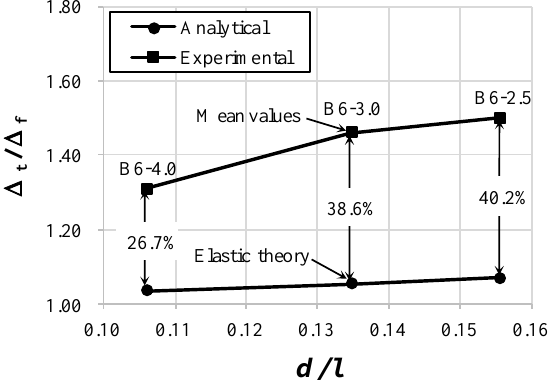
Figure 6. Comparison between experimental and elastic analytical results at flexural yield.